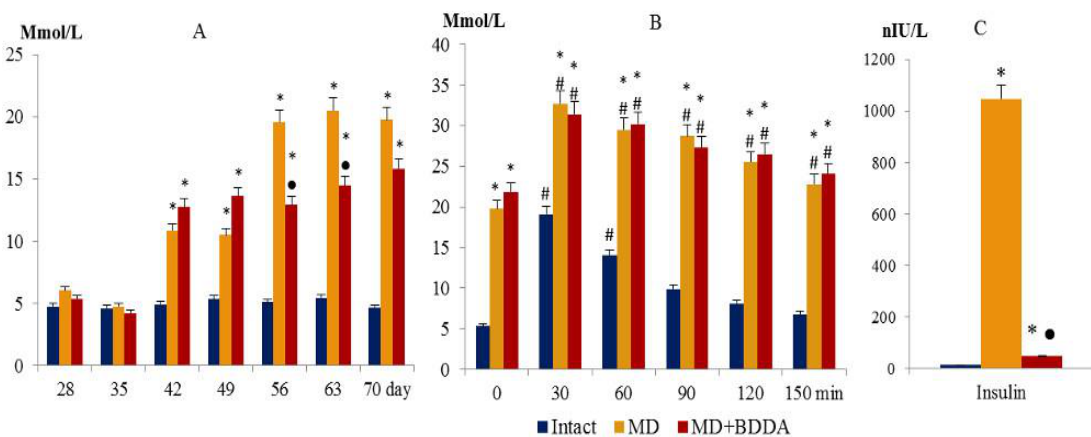
Figure 2. Blood glucose level ( A ), glucose tolerance test ( B ), and insulin level in serum of mice at d70 ( C ). Groups: intact—a control group from intact mice, MD—mice with MD, MD + BDDA—mice with MD treated BDDA. Results are presented as the mean ± SEM. *: significance of difference compared with intact ( p < 0.05); ●: significance of difference compared with the MD group (p < 0.05). #: significance of difference compared with the baseline (0) ( p < 0.05).